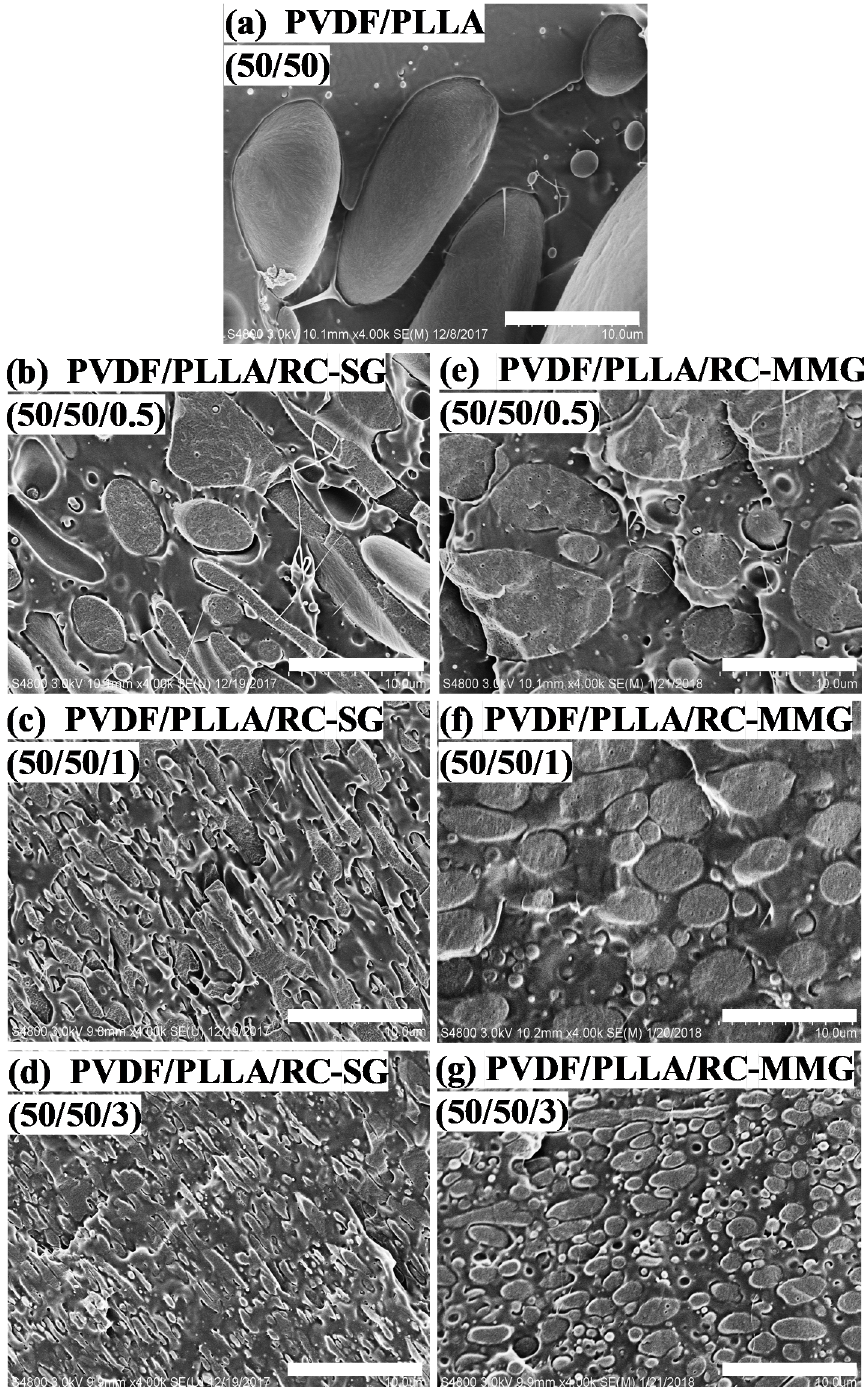
Figure 1. SEM micrographs of PVDF/PLLA (50/50, w/w) blends with various RC–SG or RC–MMG contents: ( a ) 0 wt.% compatibilizer, ( b – d ) 0.5 wt.%,1 wt.% and 3 wt.% RC–SG, ( e – g ) 0.5 wt.%, 1 wt.% and 3 wt.% RC–MMG. The white bar denotes 10 μ m.